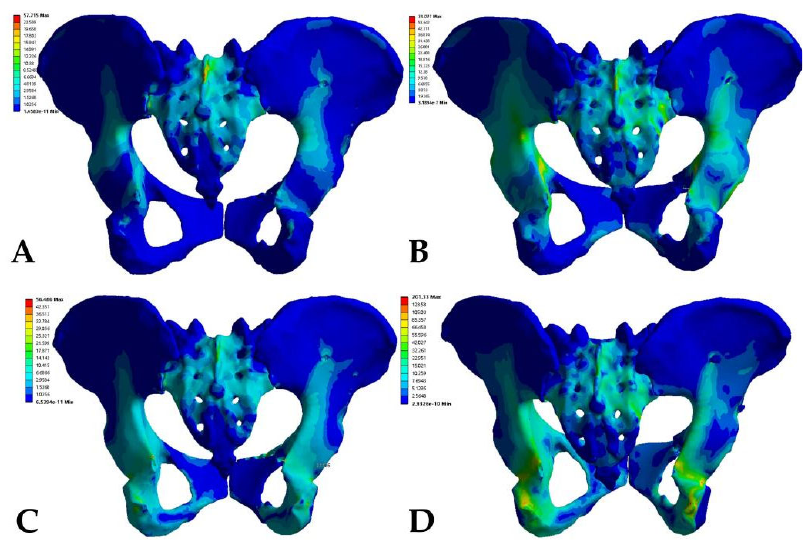
Figure 5. Von Mises stress distribution of pelvic models fixed with different implants in standing position. ( A ) Anterior ring plate. ( B ) Anterior ring hollow screw. Von Mises stress distribution of pelvic models fixed with different implants in sitting position. ( C ) Anterior ring plate. ( D ) Anterior ring hollow screw.